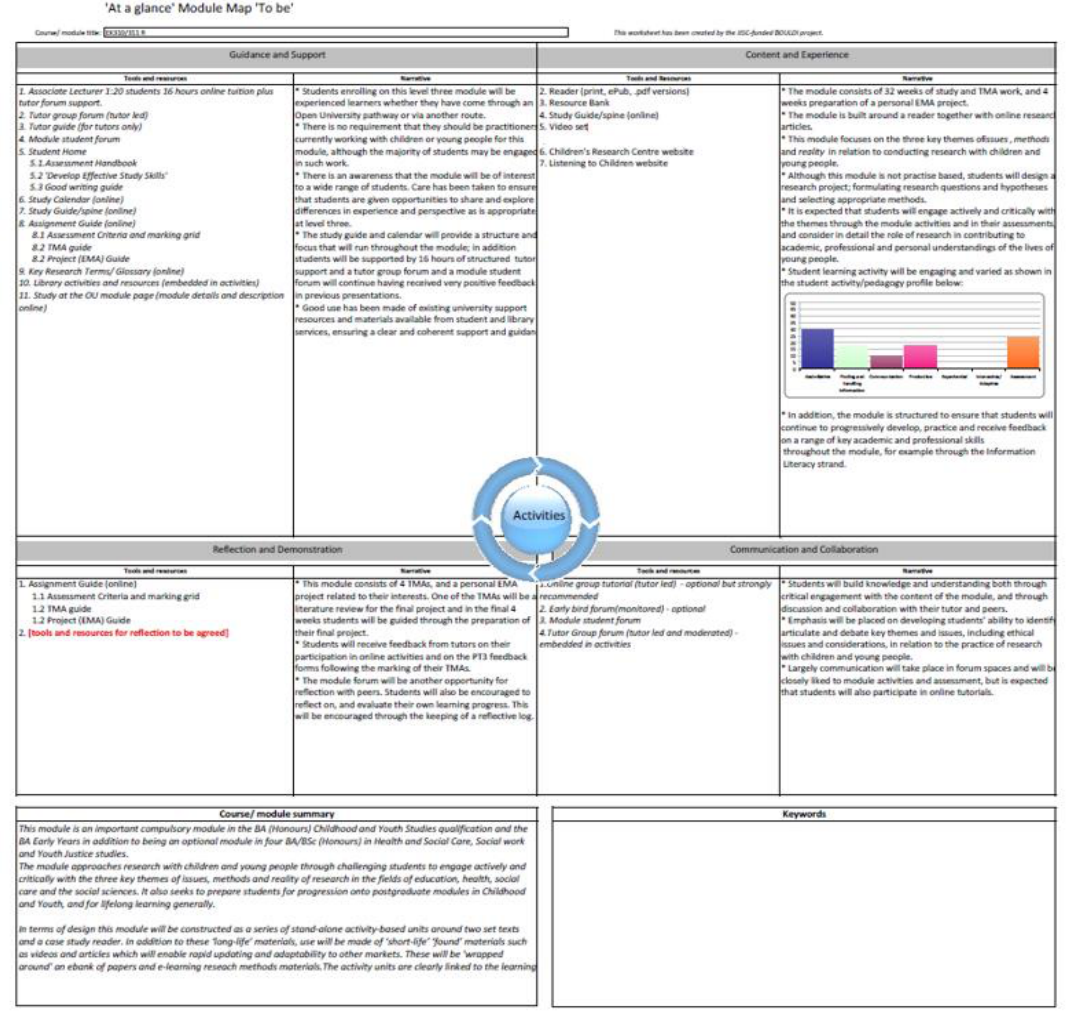
Figure 1. Module Map for new planned